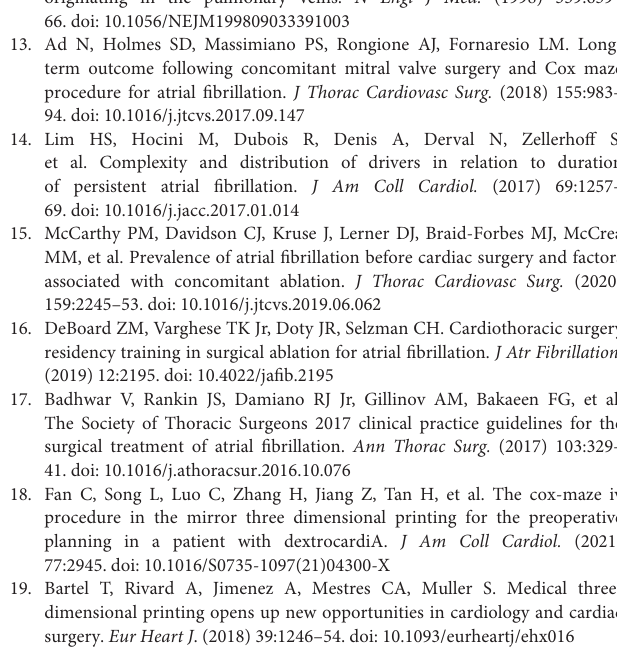
Supplementary Video 1 | Transesophageal echocardiography showed severe mitral regurgitation. Supplementary Video 2 | Demonstration of the material used for 3D